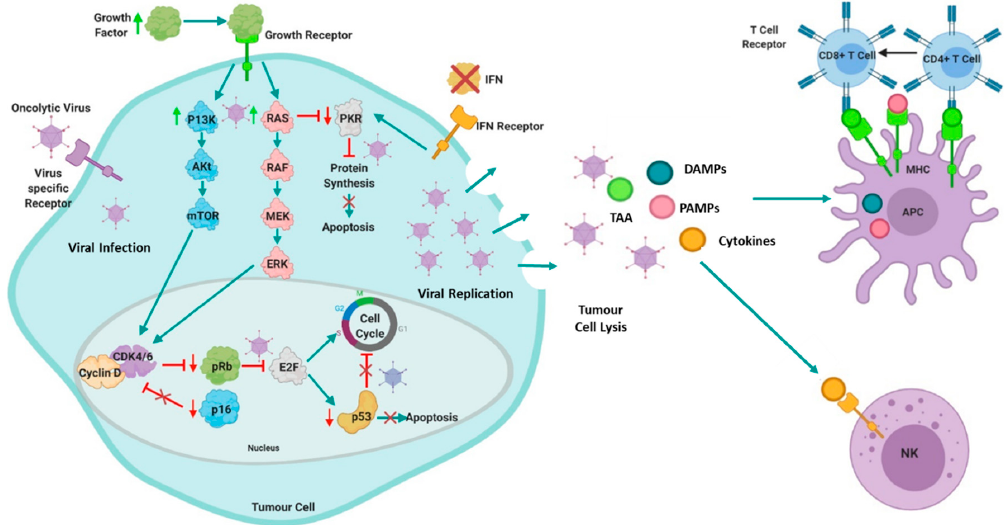
Figure 1. Mechanisms of action of oncolytic viruses: Cancer cells provide a superior environment for oncolytic viral replication due to the presence of aberrant signalling pathways or targeted molecules (such as RAS, PKR, P13K/Akt/mTOR, IFN, p53 or Rb/E2F/p16). Hyperactivation of P13K/Akt/mTOR and RAS pathways and consequent activation of their